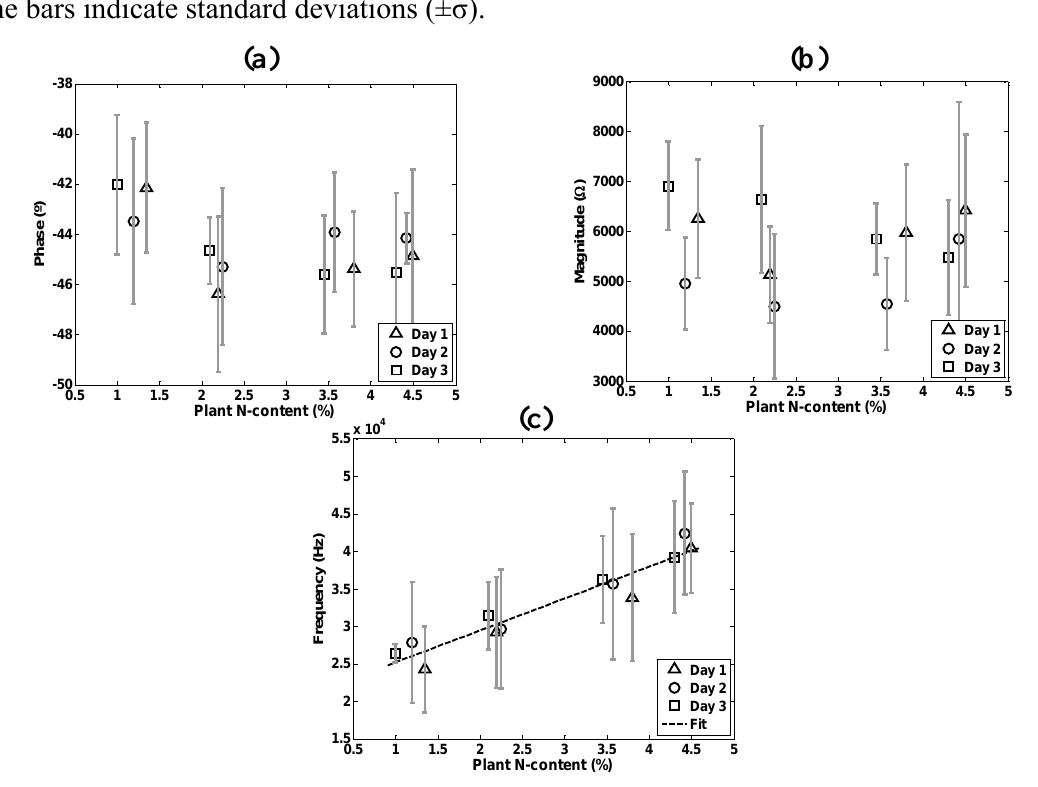
Figure 4 . Relationships between each of φ ( a ) N-content vs. φ , ( b ) N-content vs. Z min and f a fitting function was generated using averaged data (n = 5) per treatment (R 2 = 0.99). min The bars indicate standard deviations (±σ).